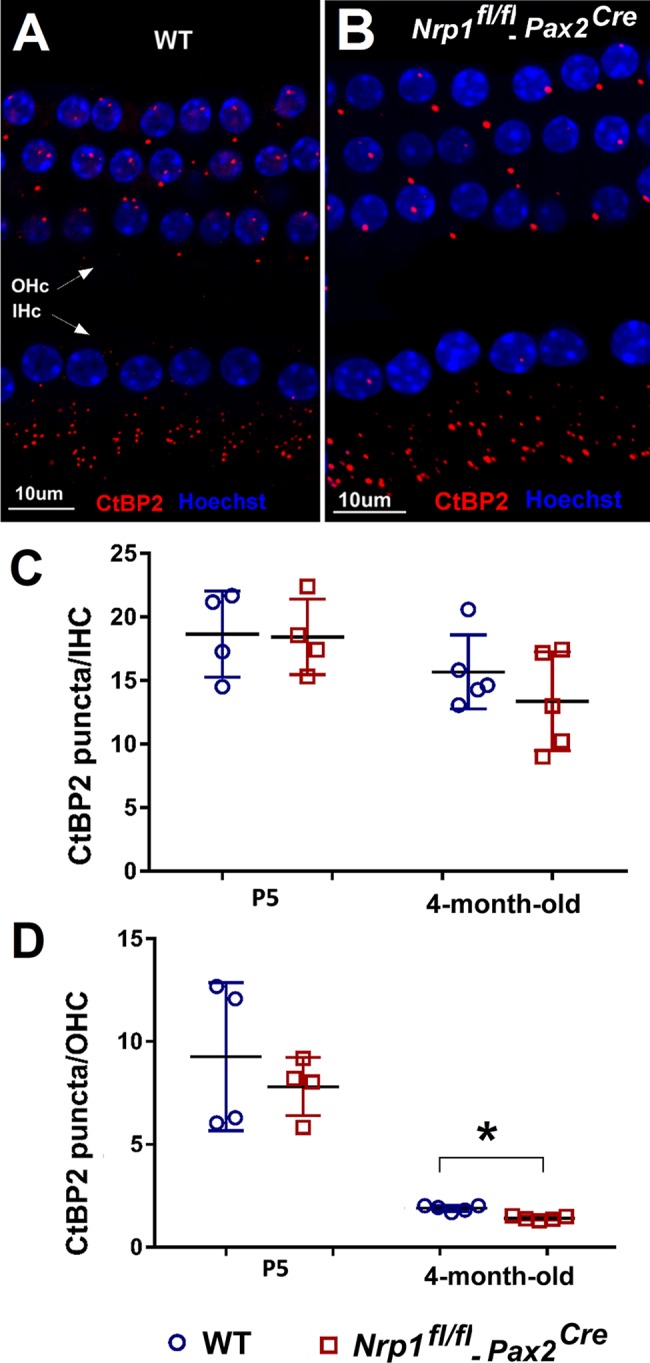
Presynaptic marker CtBP2 counts of the IHCs and OHCs.Cochlear whole mounts of WT, Nrp1fl/fl;Pax2Cre mice at P5 (n = 4 per group) and 4 months (n = 5 per group) were immunostained with presynaptic marker CtBP2. Panel A and B shows CtBP2 immunostaining of the 4-month-old mice (A, B). The number of CtBP2 puncta was compared separately to the number of inner and outer hair cells per section. CtBP2 ratios of IHCs did not differ significantly between WT and Nrp1fl/fl;Pax2Cre mutants from P5 to maturity (C). OHC synaptic ribbon ratios of 4-month-old Nrp1fl/fl;Pax2Cre demonstrated a significant decrease in CtBP2 counts in the basal turn (p<0.05). CtBP2 counts of the IHCs showed two cochlea out of five with nearly 50% decreased numbers of the puncta when compared to WT controls; however, the average of the counts (five cochlea) did not show a statistically significant difference (D). *p<0.05. Scale bar = 10 μm.